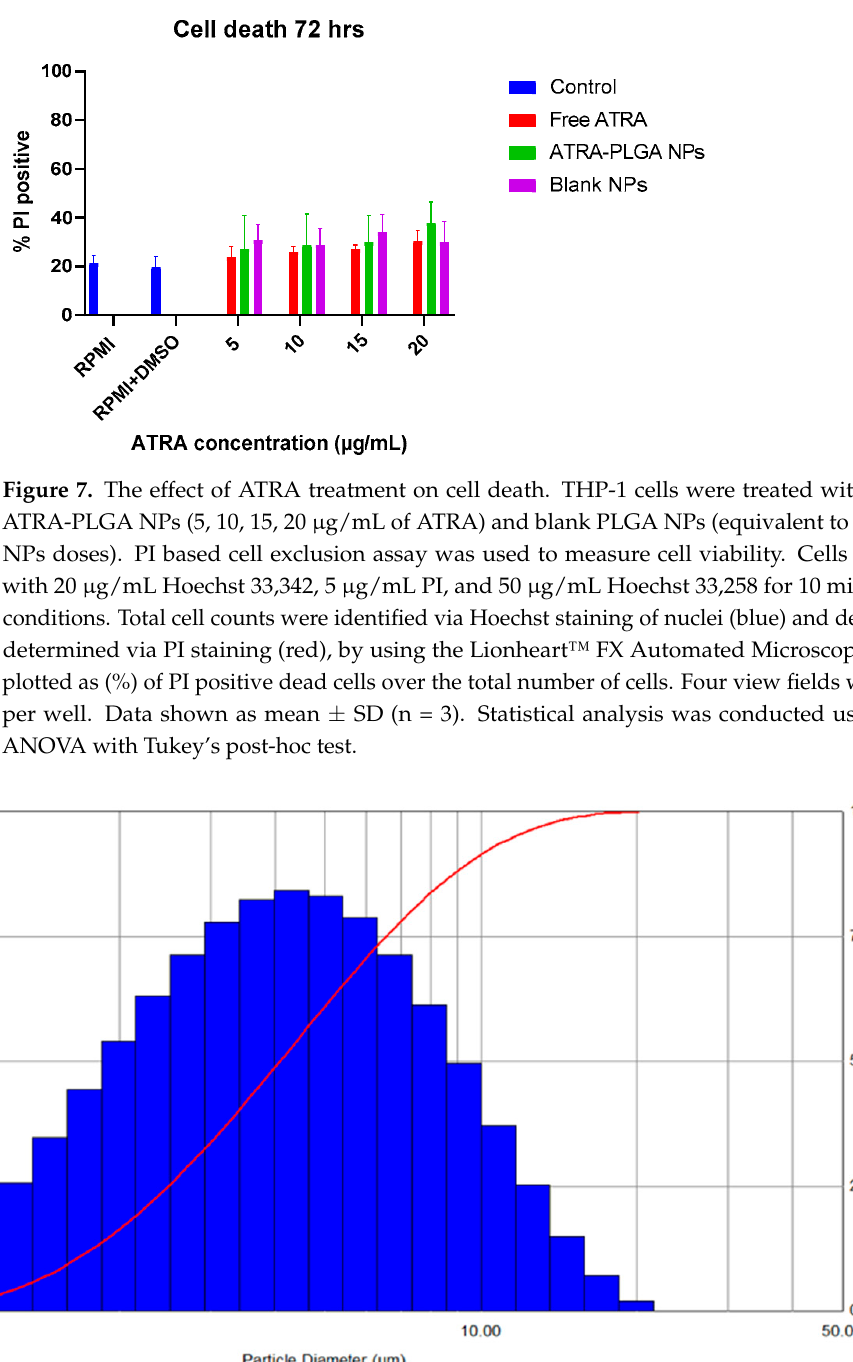
using Aerogen Solo VMN as measured by laser diffraction via Malvern Spraytec.